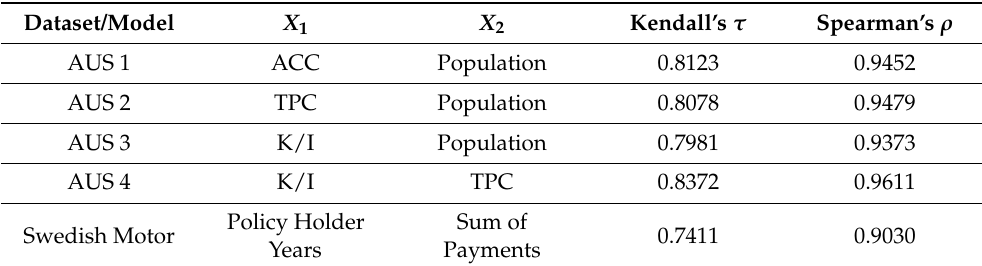
Table 2. Level of dependence between model variables.